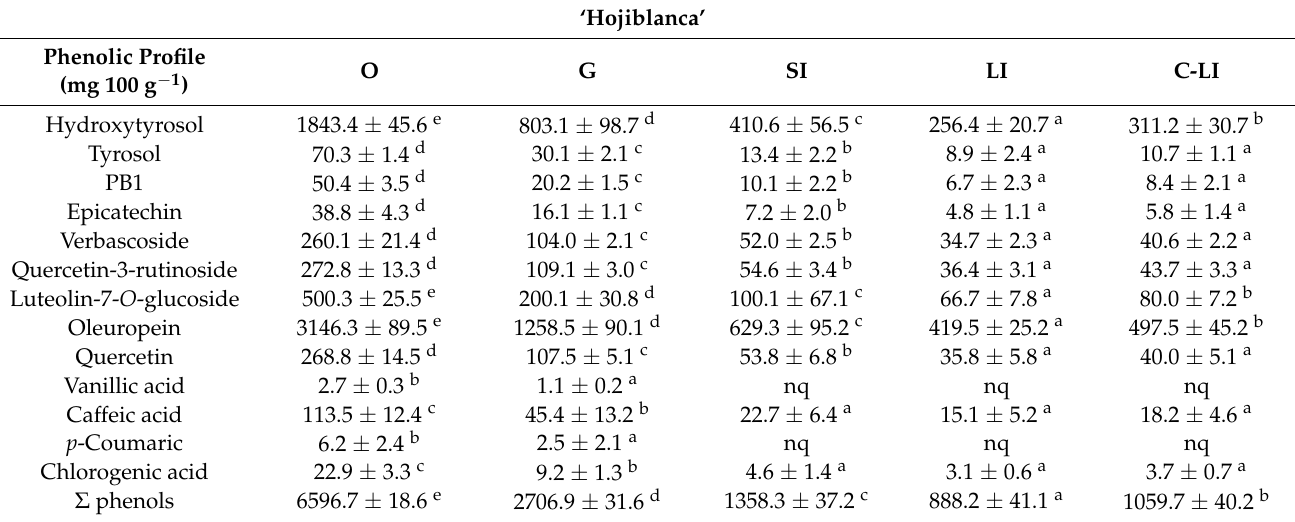
Table 4. Polyphenol compounds (mg 100 g − 1 ) of Californian-style table olives after addition of aqueous OLE and submitted to in vitro gastrointestinal